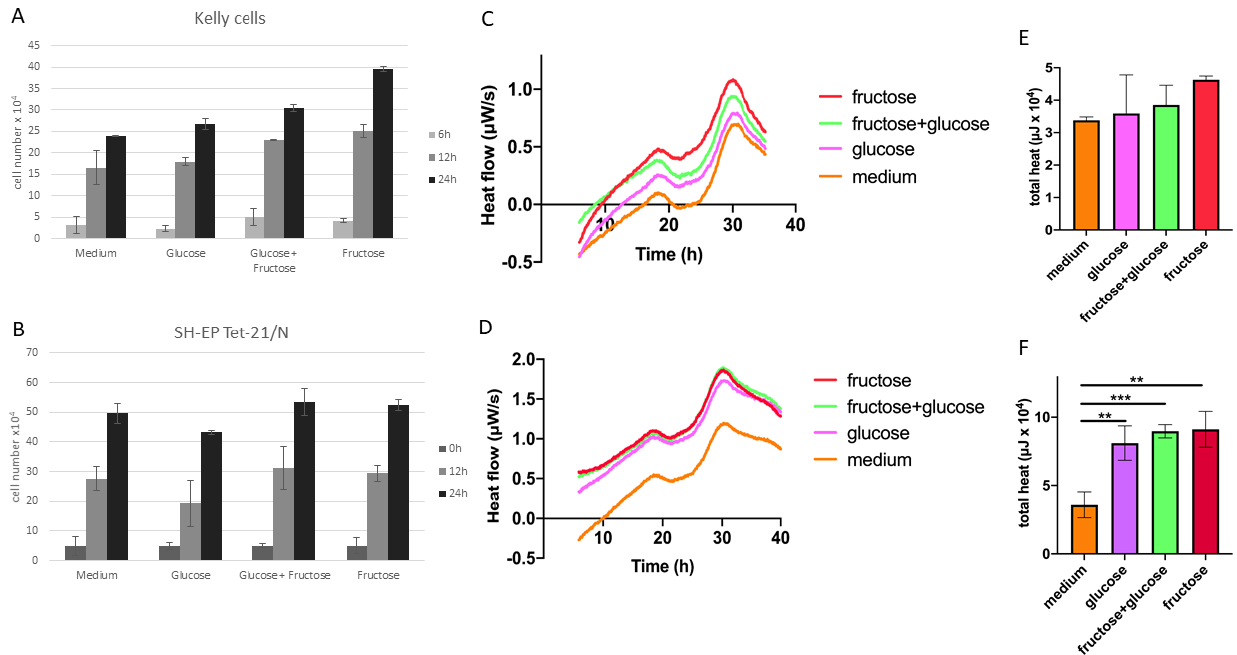
Figure 1. ( A , B ) show proliferation of Kelly and SH-EP Tet-21/N cells, respectively, in medium, glucose-enriched, fructose/glucose-enriched and glucose-enriched medium over time. Proliferation is increased after addition of fruc- tose, especially in Kelly cells. SH-EP Tet-21/N cells do not show this effect so clearly. However, the overall proliferation level in SH-EP Tet-21/N cells is higher under the influence of fructose and fructose/glucose compared to glucose and medium alone. ( C , D ) present the thermogenic curve of Kelly and SH-EP Tet-21/N cells, respectively, in medium, glucose- enriched, fructose/glucose-enriched and glucose-enriched medium as heat flow ( µ W/s) over time (h). Fructose-treated Kelly cells clearly show an increased heat flow compared with glucose- and fructose/glucose-treated cells or cells in medium alone. SH-EP Tet-21/N cells show increased heat flow in both fructose and fructose/glucose-treated cells, closely followed by glucose alone (** p < 0.01 compared to medium). SH-EP Tet-21/N cells grown in medium alone show lower thermogenic activity. ( E , F ) show the overall heat of treated cells in total heat ( µ J × 10 4 ) over the observation period. SH-EP Tet-21/N cells show significantly increased overall heat, to the greatest extent in fructose (** p < 0.01 compared to medium) and fructose/glucose-treated cells (*** p < 0.001 compared to medium), followed by glucose alone (** p < 0.01 compared to medium). The overall heat mirrors the heat